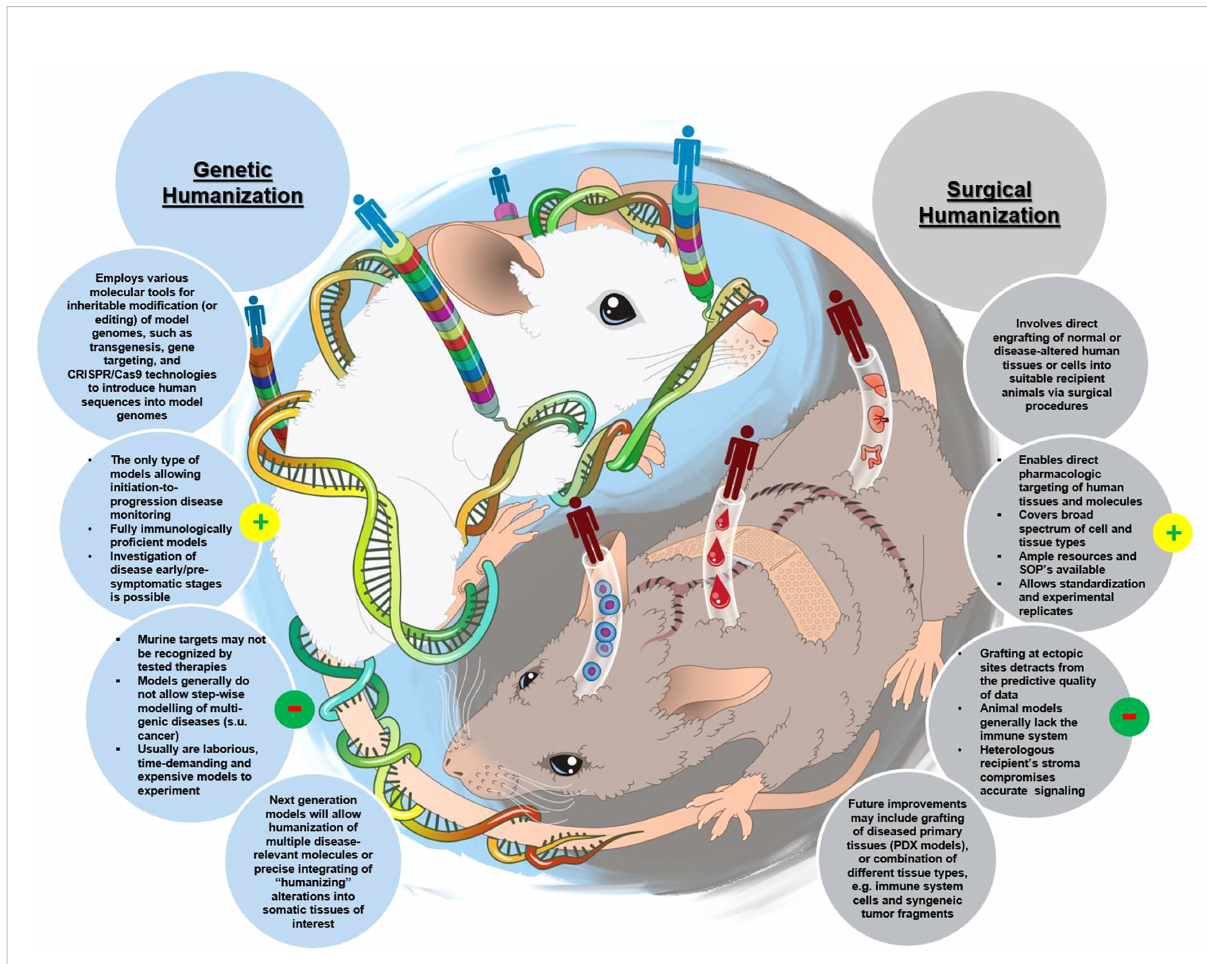
FIGURE 8 Complementary approaches in establishing humanized animal models for basic and translational research purposes. Key bene fi ts (highlighted as yellow circle with a plus sign inside) versus shortcomings (highlighted as a green circle with a minus sign inside) of both strategies are listed, as well as anticipated future directions toward improved utility of these models for preclinical drug-assessment studies. This fi gure is reproduced with permission from (254).